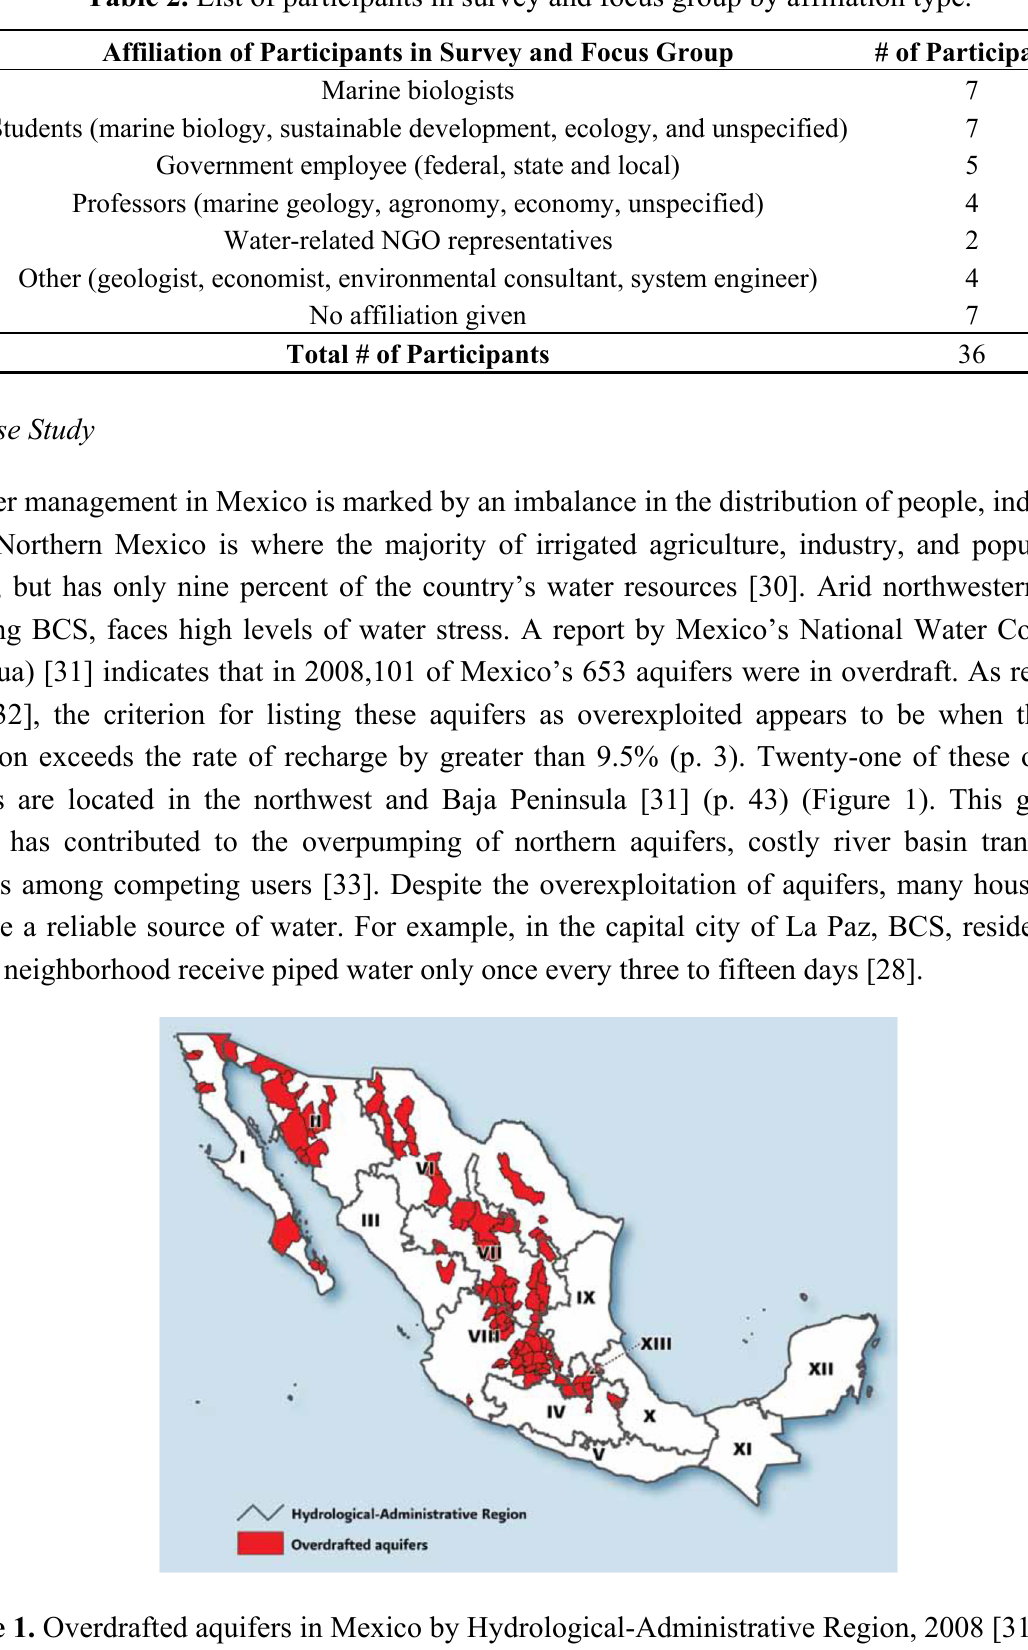
Table 2. List of participants in survey and focus group by affiliation type.